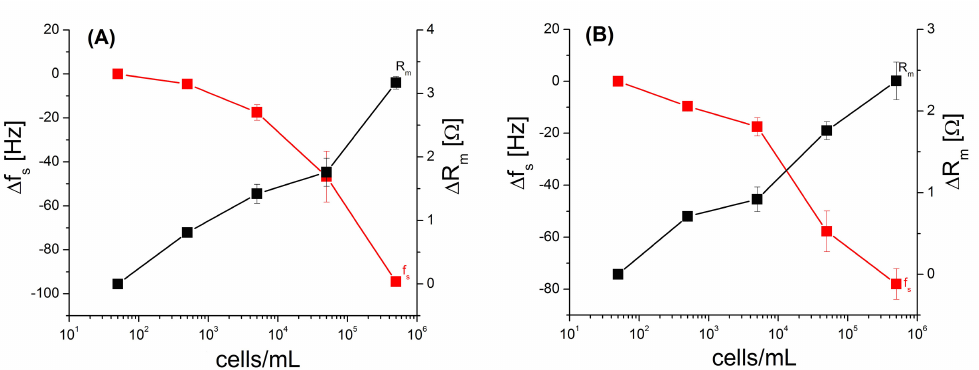
Figure 6. The plot of the ∆ f s and ∆ R m as a function of the concentration of HER2 + cells SK-BR-3 for aptasensors based on HeA2_3 ( A ) and HB5 ( B ) aptamers. Results represent mean ± SD obtained from 3 independent experiments in each series.